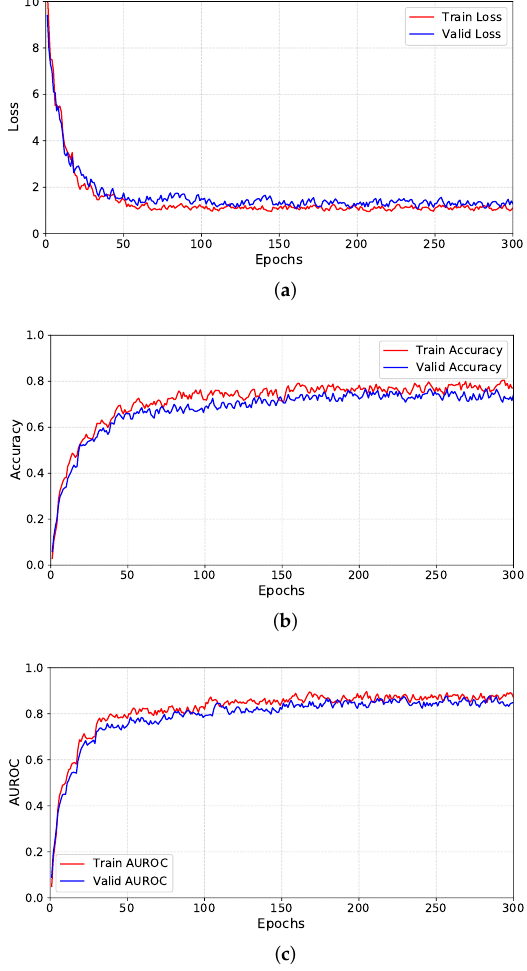
Figure 8. The loss plot, accuracy plot, and AUROC plot of the proposed HGAFMN. ( a ) loss plot, ( b ) accuracy plot, ( c ) AUROC